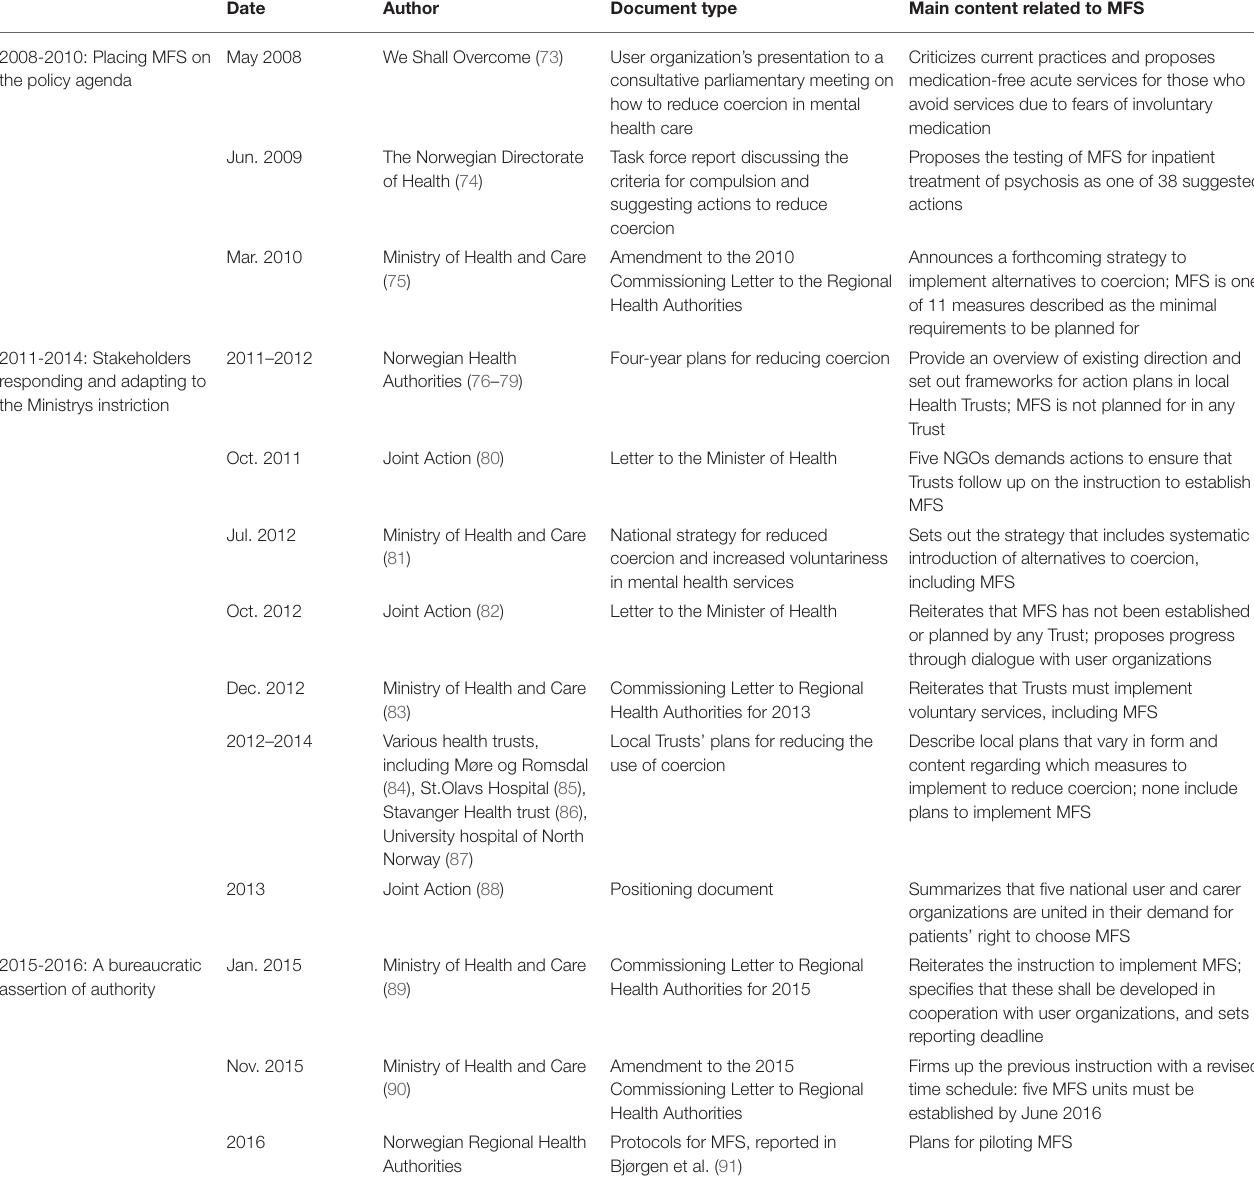
TABLE 1 | Sequence of key arguments and documents* related to the introduction of medication-free services (MFS) in